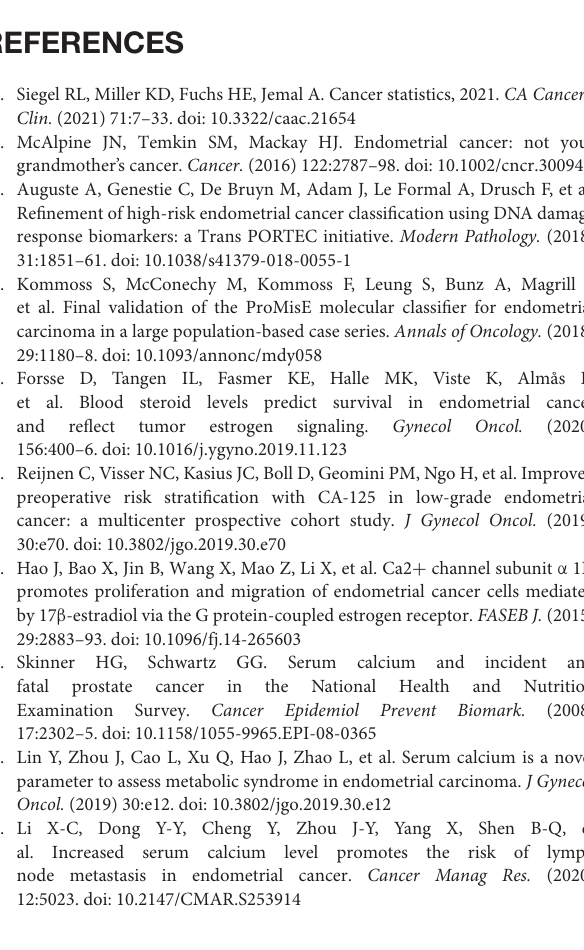
Supplementary Figure 1 | E2-BSA induced calcium influx promoted cell migration in Ishikawa cells. Wound-healing assay for Ishikawa cells